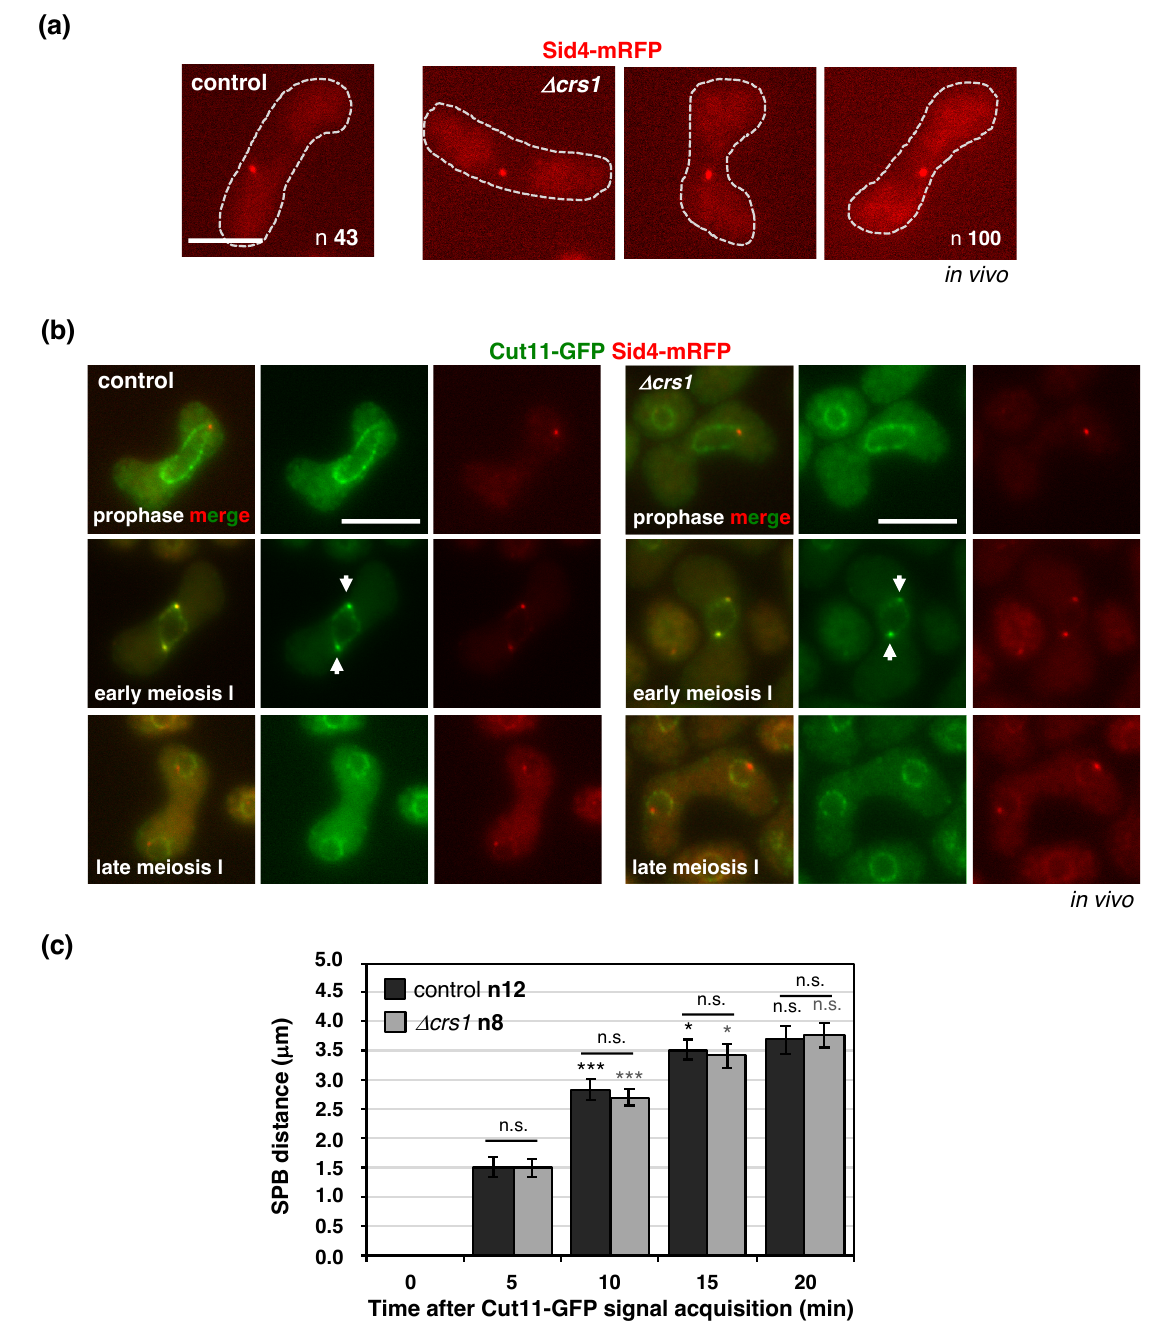
Figure 8. SPB insertion and separation in crs1 deletion mutants. ( a ) In vivo Sid4-mRFP signal (SPB) in prophase in h 90 wild-type (CMC1027) and crs1 mutant (CMC1388) zygotes. Pooled data of two independent experiments with a total of 43 control and 100 crs1 zygotes analyzed. Images are single planes. ( b ) In vivo Cut11-GFP and Sid4-mRFP localization in prophase and meiosis I in h 90 wild-type (CMC1441) and crs1 mutant (CMC1444) zygotes. Notice Cut11-GFP signal acquisition at the SPB (Sid4-mRFP) upon insertion in the nuclear membrane in early meiosis I (arrowheads). Images are either single planes or maximal projections of Z sections. ( c ) Quantification of SPBs separation after nuclear membrane insertion (Cut11-GFP signal acquisition) in time lapse experiments. Time 0 corresponds to the first time point in which Cut11-GFP was observed at the SPB (insertion). Pooled data of two independent experiments with a total of 12 control and 8 crs1 zygotes analyzed. For each genotype, p value was calculated at each time point by comparison with the previous time point. In addition, control and crs1 mutant were compared at each time point. No statistical differences between control and crs1 mutant zygotes were observed. p value * < 0.05, *** ≤ 0.001 (Student’s t -test, unpaired, two tails). n. s. No statistically significant difference. Scale bar corresponds to 5 µ m. Related to Videos